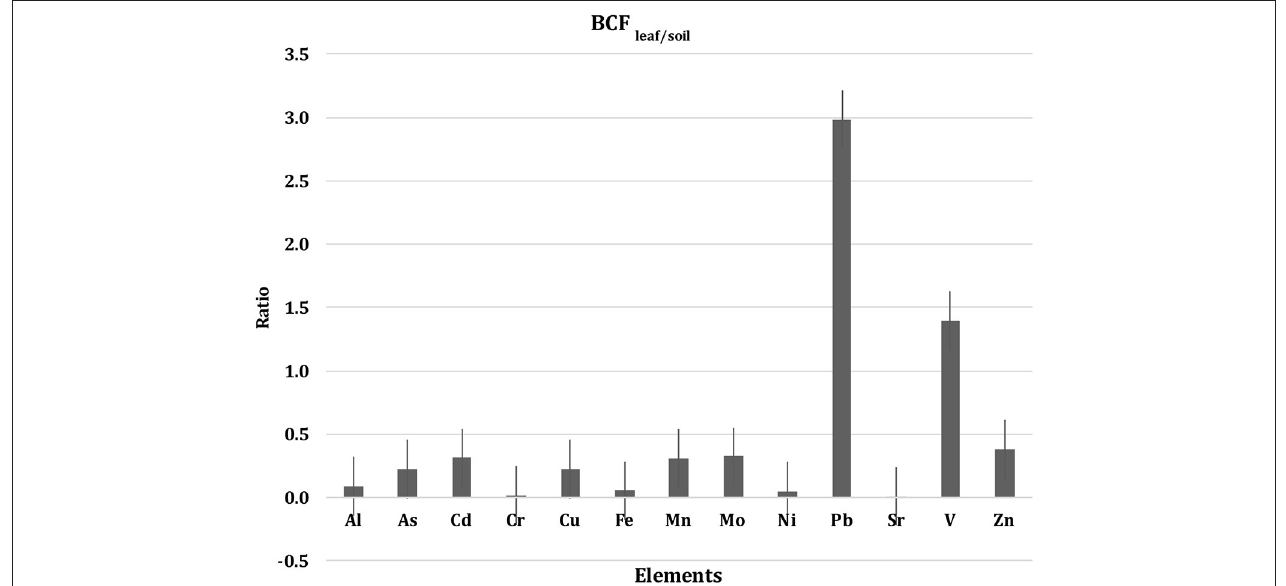
FIGURE 6 | Bioaccumulation factor (BCF), representing the ratio of the average metal concentrations in the leaf to soil, combining all four locations (Mean ± SE).